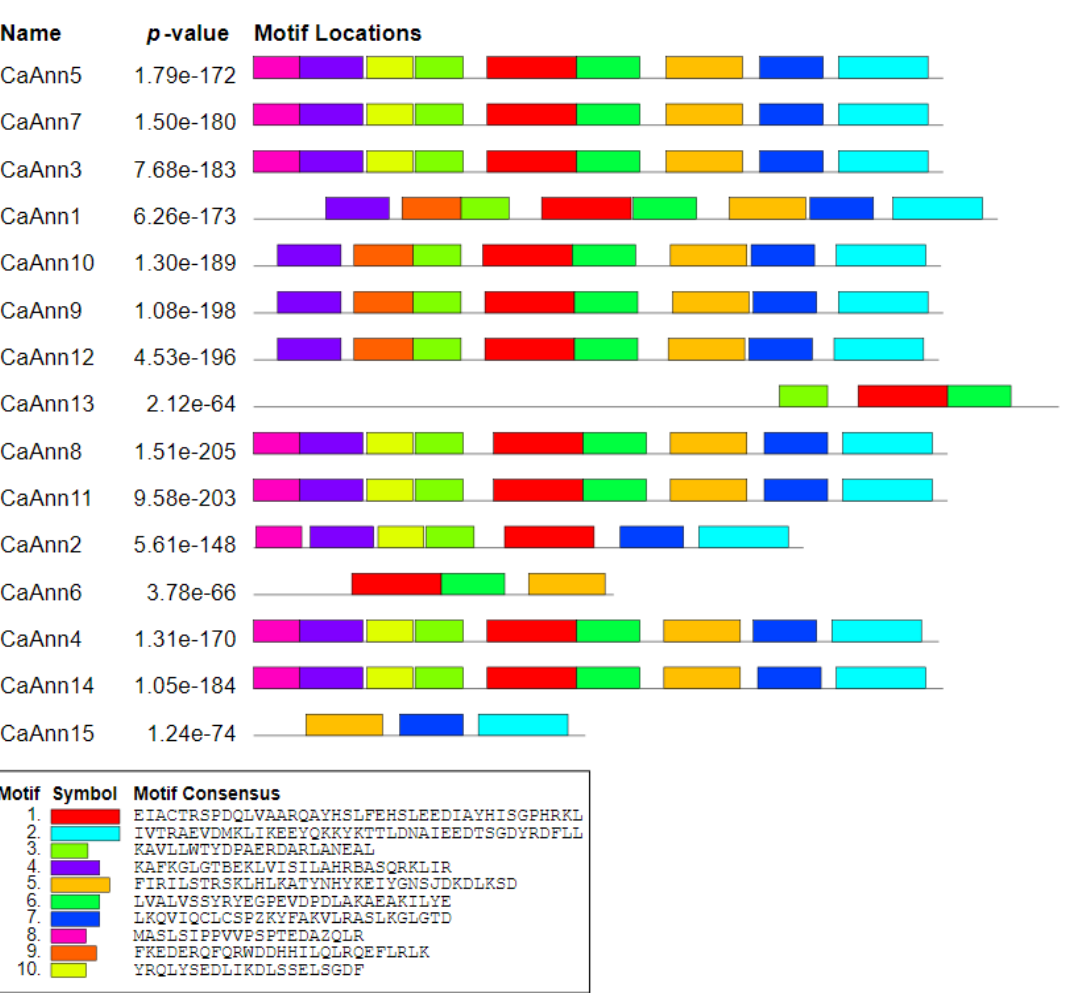
Figure 3. Motif distributions of pepper CaAnn proteins. Ten themes were identified by MEME tool search and are represented by different colors. As described in the methods, Meme online software (Version 5.3.3 http://memesuite.org/tools/meme) was used. The annexin proteins are listed on the left. The different colored boxes represent different motifs and their position in each annexin sequence. The sequences of key motifs are shown on the bottom of the figure.